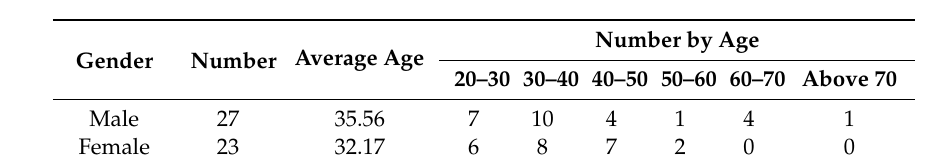
Table 2. Details of participants.